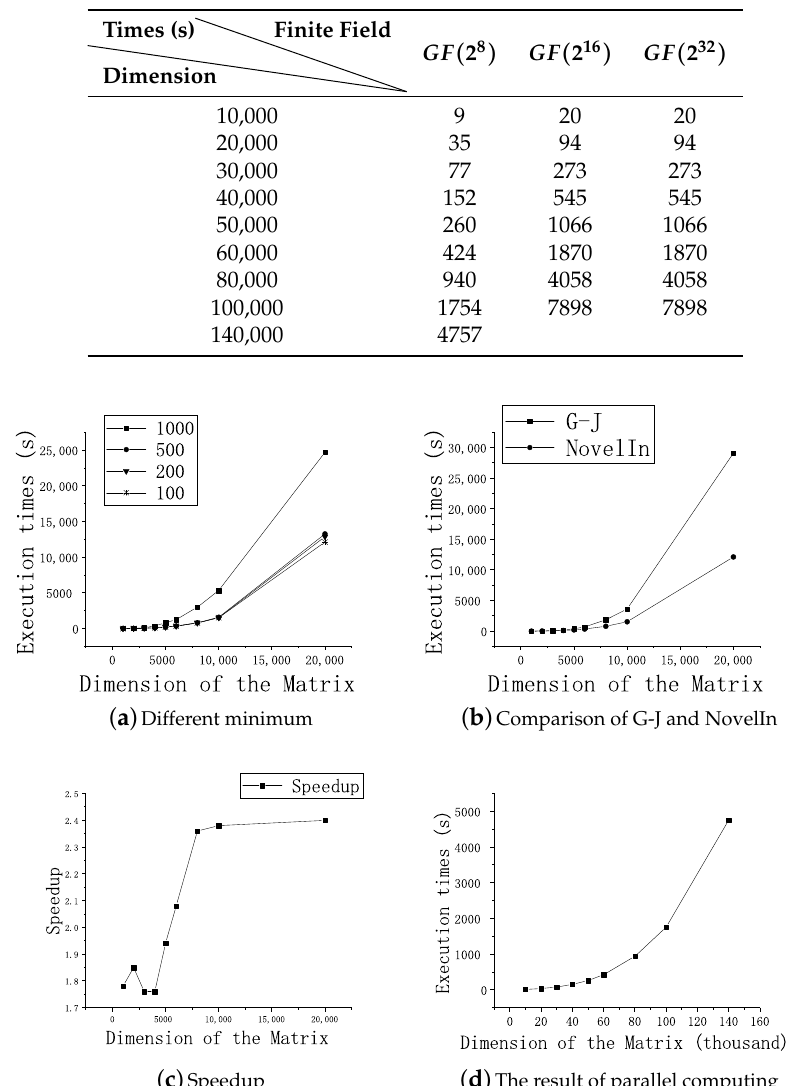
Table 3. The results on the supercomputing center.